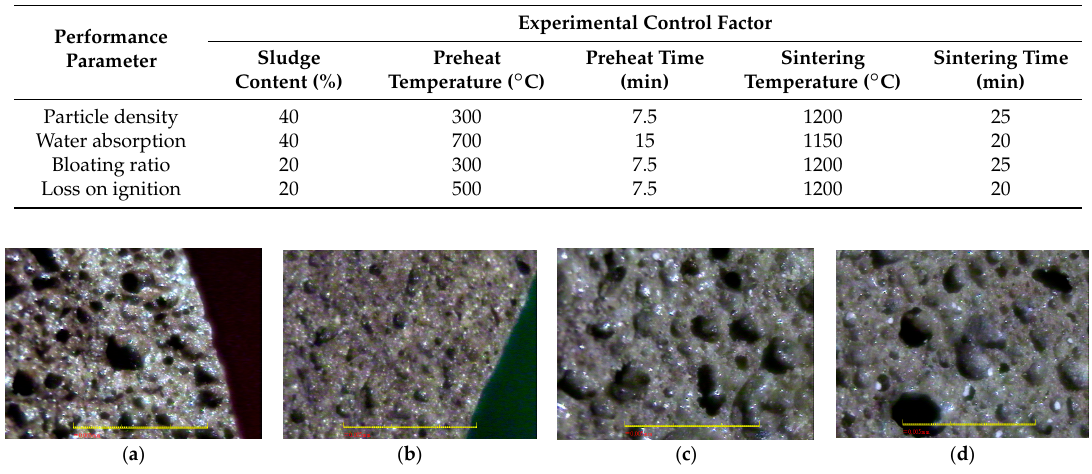
Table 15. Process parameters and design levels.